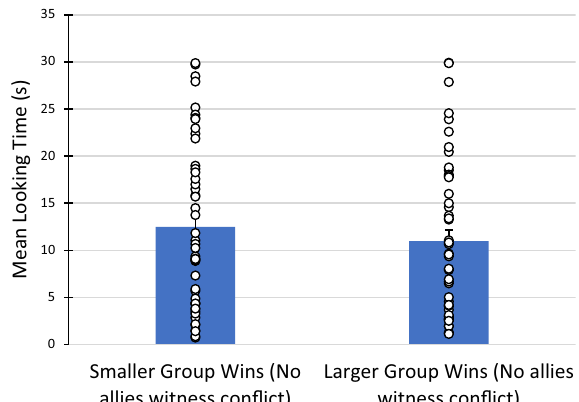
Figure 4. Mean looking time to trial depicting smaller group winning compared to trial depicting larger group winning for 9–12 month old infants (within-subjects). Individual data points are depicted. Error bars denote SE of the